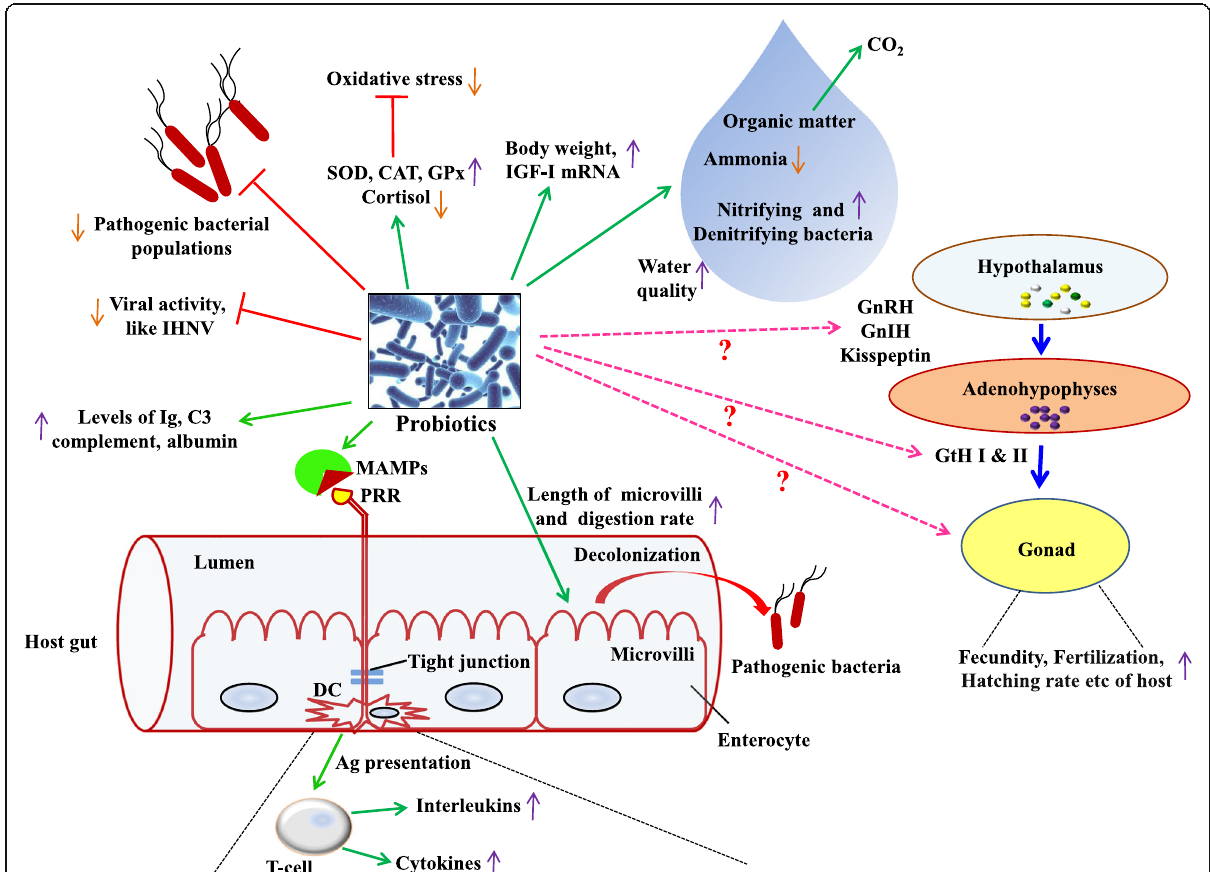
Fig. 2 Diagrammatic presentation of the summary of information gathered from the studies on different aquatic organisms to explain the possible role of probiotics in aquaculture system. Probiotics improve (indicated by upwards arrow) body weight, digestion rate, surface area of microvilli, antioxidative enzymes, stress tolerance, immune response, fecundity, fertilization of the host, as well as water quality of the aquatic environment. It also downregulates (indicated by downwards arrow) pathogenic bacteria and their enteric colonization, viral activity, cortisol level in host organisms. But the effects of probiotics on the reproductive axis of aquatic animals are still lacking (indicated by question mark). Ag antigen, CAT catalase, DC dendritic cell, GnIH gonadotropin-inhibiting hormone, GnRH gonadotropin-releasing hormone, GPx glutathione peroxidase, GtH gonadotropin, Ig immunoglobulin, IGF - I insulin-like growth factor-I, IHNV infectious hematopoietic necrosis virus, MAMPs microbial-associated molecular patterns, PRR pathogen pattern recognition receptors, SOD superoxide